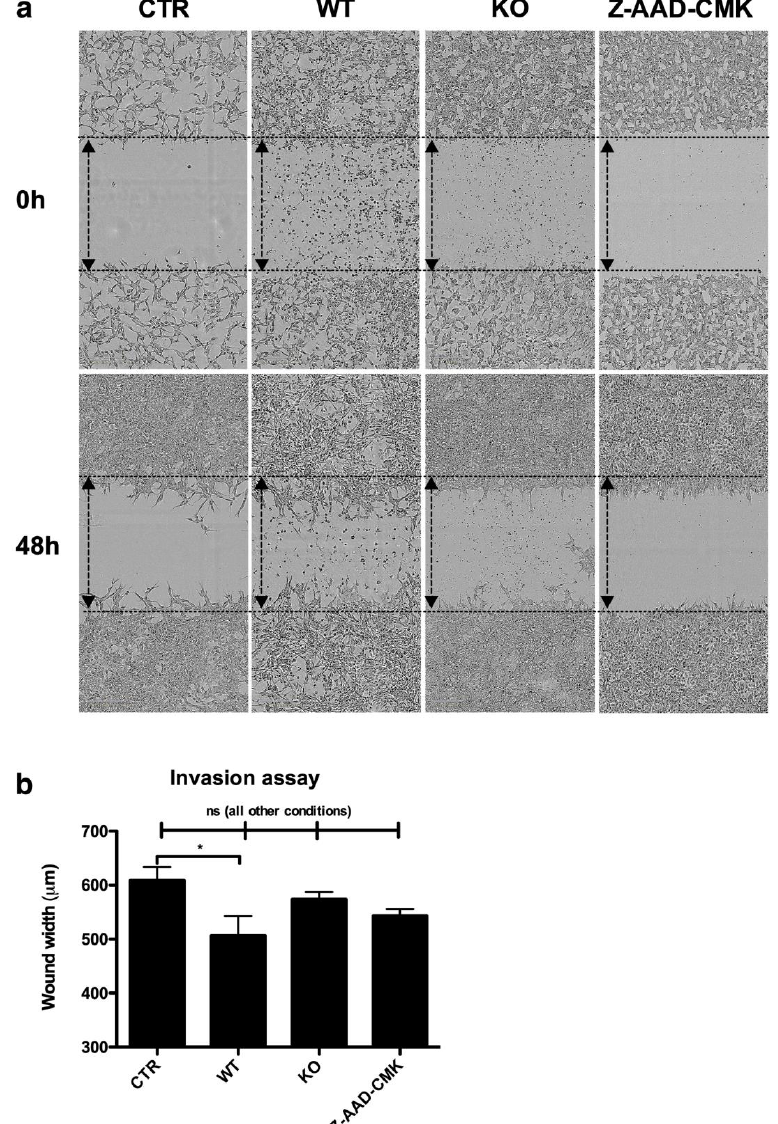
Figure 5. GzmB expressed by MDSCs facilitate migration of tumor cells. ( a ) Representative images of the in vitro invasion assay after 48 h incubation. ( b ) Summarizing graph of the in vitro invasion assay showing the wound width after 48 h of incubation. The following conditions were shown: B16F10 cells alone (CTR), B16F10 cells supplemented with WT MDSCs (WT), B16F10 cells supplemented with KO MDSCs (KO), and B16F10 cells supplemented with WT MDSCs and the GzmB inhibitor Z-AAD-CMK (10 µ M) (Z-AAD-CMK), respectively. The mean +/ -SEM of at least fivw data points is shown. A student’s t-test was used to calculate the statistical significance. The number of asterisks in the figures indicates the level of statistical significance as follows: ns, > 0.05 and *, p < 0.05.